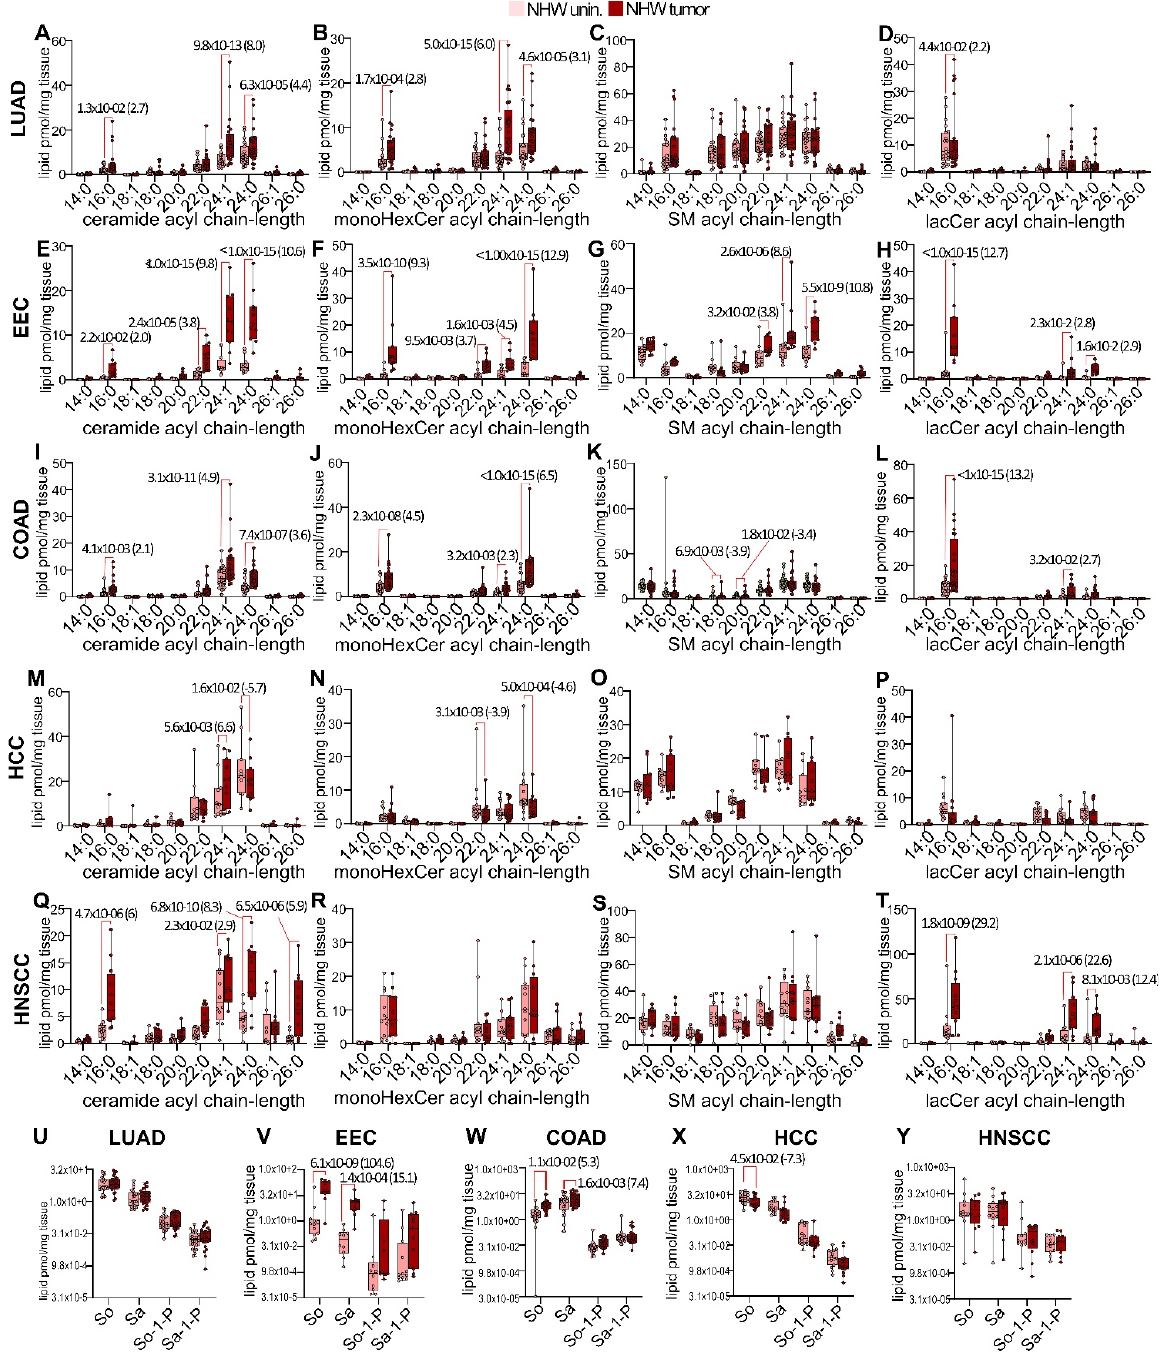
Figure 3. Sphingolipid profiles of normal adjacent uninvolved tissues and tumors of self-identified NHW males diagnosed with LUAD, COAD, HCC, and HNSCC and of self-identified NHW females with EEC. The indicated chain-length sphingolipids were quantified by LC-ESI-MS/MS in normal adjacent uninvolved tissues (unin.) and tumors of self-identified NHW subjects with primary histopathologic confirmed diagnoses of lung adenocarcinoma (LUAD; panels ( A – D , U )), endometrial endometroid carcinoma (EEC; panels ( E – H , V )), colorectal adenocarcinoma (COAD; panels ( I – L , W )), hepatocellular adenocarcinoma (HCC; panels ( M – P , X )), and head and neck squamous cell carcinoma (HNSCC; panels ( Q – T , Y )). Lipid levels are shown as the amount of picomoles of indicated chain length and lipid species per mg of tissue. For LUAD, unin. n = 22, tumor n = 26; EEC, n = 12; COAD, n = 24; HCC, n = 11; HNSCC, n = 12. Graphs are box plots showing medians (black line) and